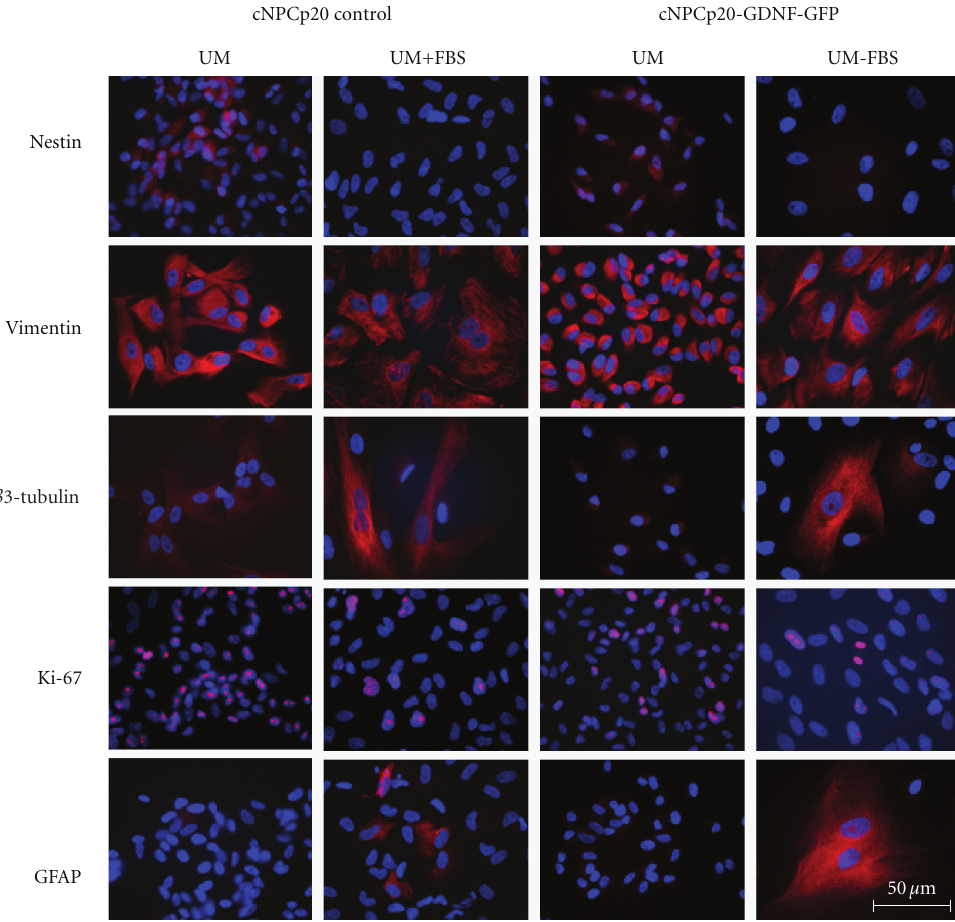
Figure 8: Expression of NPC and lineage markers before and after transduction and di ff erentiation. The e ff ects of passage number, induction of di ff erentiation and GDNF transgene expression on the expression of 5 markers was evaluated using ICC. Nontransduced and lenti-GDNF- GFP vector transduced cNPCp20 were cultured in UM or UM-FBS, then immunolabeled with specific antibodies. The changes in expression patterns seen predominantly reflected exposure to di ff erentiation conditions (alternating columns), with little that might be attributable to passage number or lenti-GDNF-GFP transduction. Scale bar = 50 μ